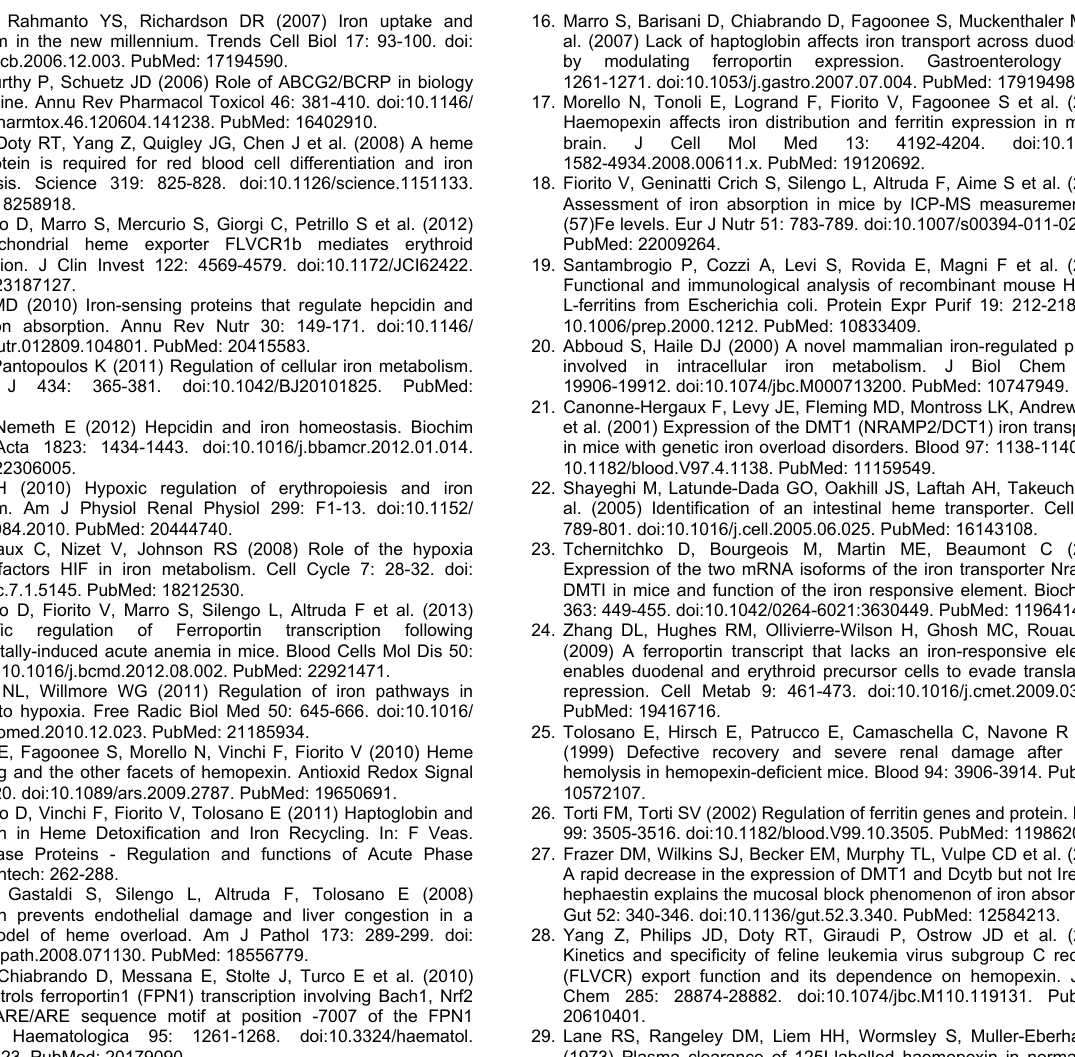
Figure S2. Hx deficiency does not affect duodenal HO-2 expression. (A) Representative Western blot of HO-2 expression in the duodenum of wild-type and Hx-null mice. Band intensities were measured by densitometry and normalized to actin expression. Densitometry data represent mean ± SEM; n=3 for each genotype. (B) Sections of the duodenum of a wild-type mouse (i, iv) and an Hx-null mouse (ii, v) stained with an antibody to HO-2. The HO-2-positive signal was comparable in the Hx-null mouse and in the wild-type control (arrows). Sections on the right (iii, vi) represent negative controls in which the primary antibody was omitted. Bar i, ii, iii = 100µm; bar iv, v, vi = 20